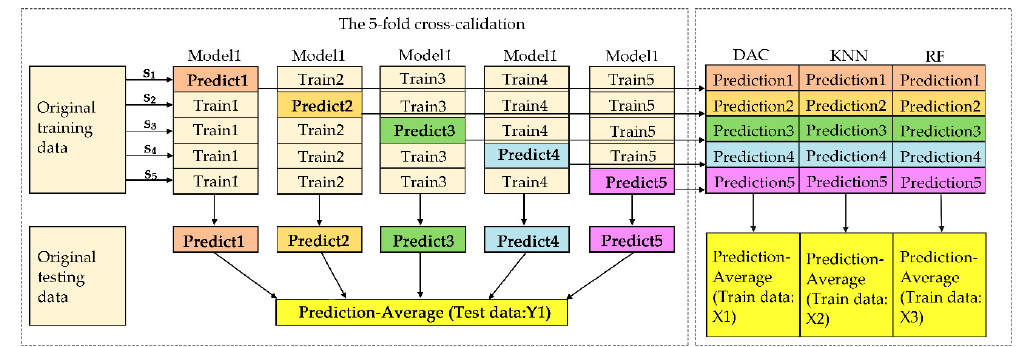
Figure 11. Training and prediction models for metamodels.